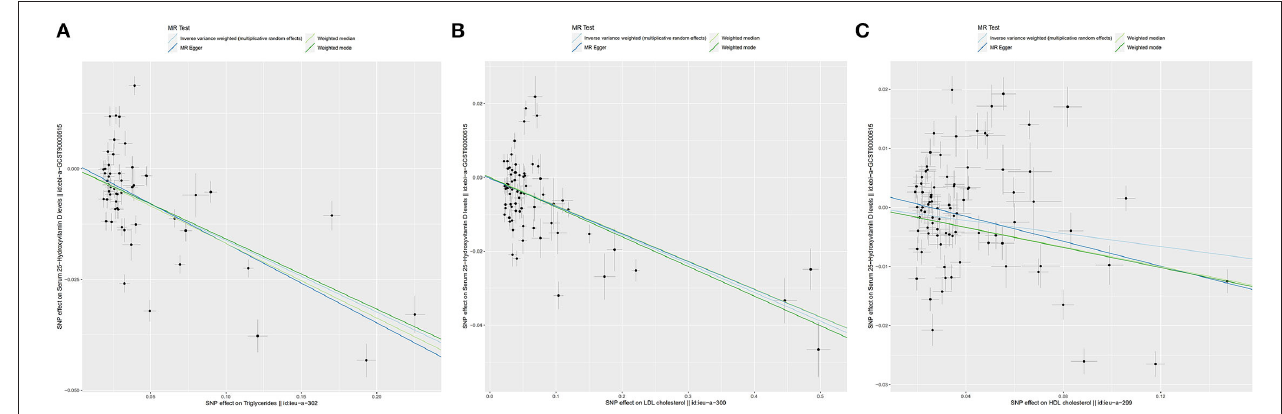
FIGURE 3 | The scatter plots for Mendelian Randomization (MR) analyses of the causal effect of lipid profile on vitamin D deficiency. Analyses were conducted by using the conventional IVW, MR-Egger, weighted median MR, weighted mode MR. The slope of each line corresponding to the estimated MR effect per method. (A)